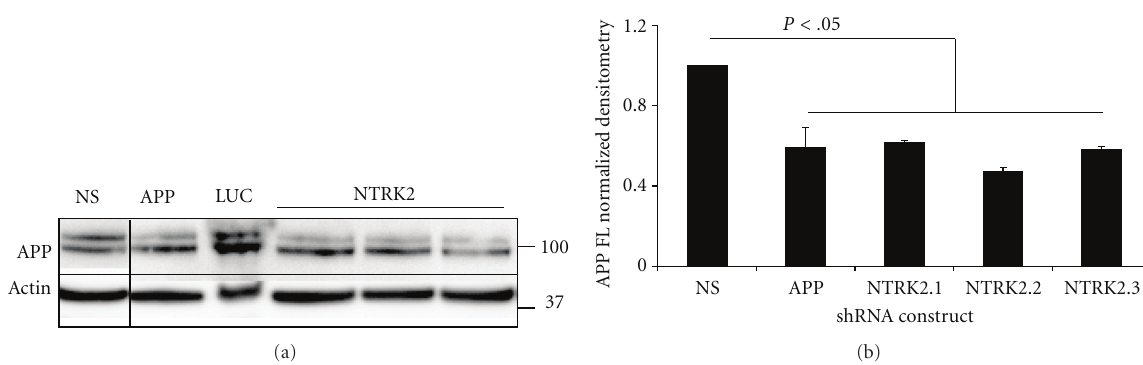
Figure 4: NTRK2 knockdown decreases APP full-length levels. (a) Representative Western Blot of APP full-length and actin as a loading control in lysates from cells transfected with shRNA constructs targeting APP , luciferase (LUC), NTRK2 and a negative, nonsilencing (NS), control. (b) Average quantification of APP full-length levels from four independent Western Blot analysis conducted on independent transfections. Within each transfection APP FL densitometry was normalized to the APP FL densitometry of the cell lysate obtained from cells transfected with CTRL shRNA. A statistically significant di ff erence was observed between CTRL and the APP or NTRK2 shRNA targeting constructs ( P < . 05). The experiment was repeated four times independently with three replicates each, error bars indicate SEM. Statistical analysis: